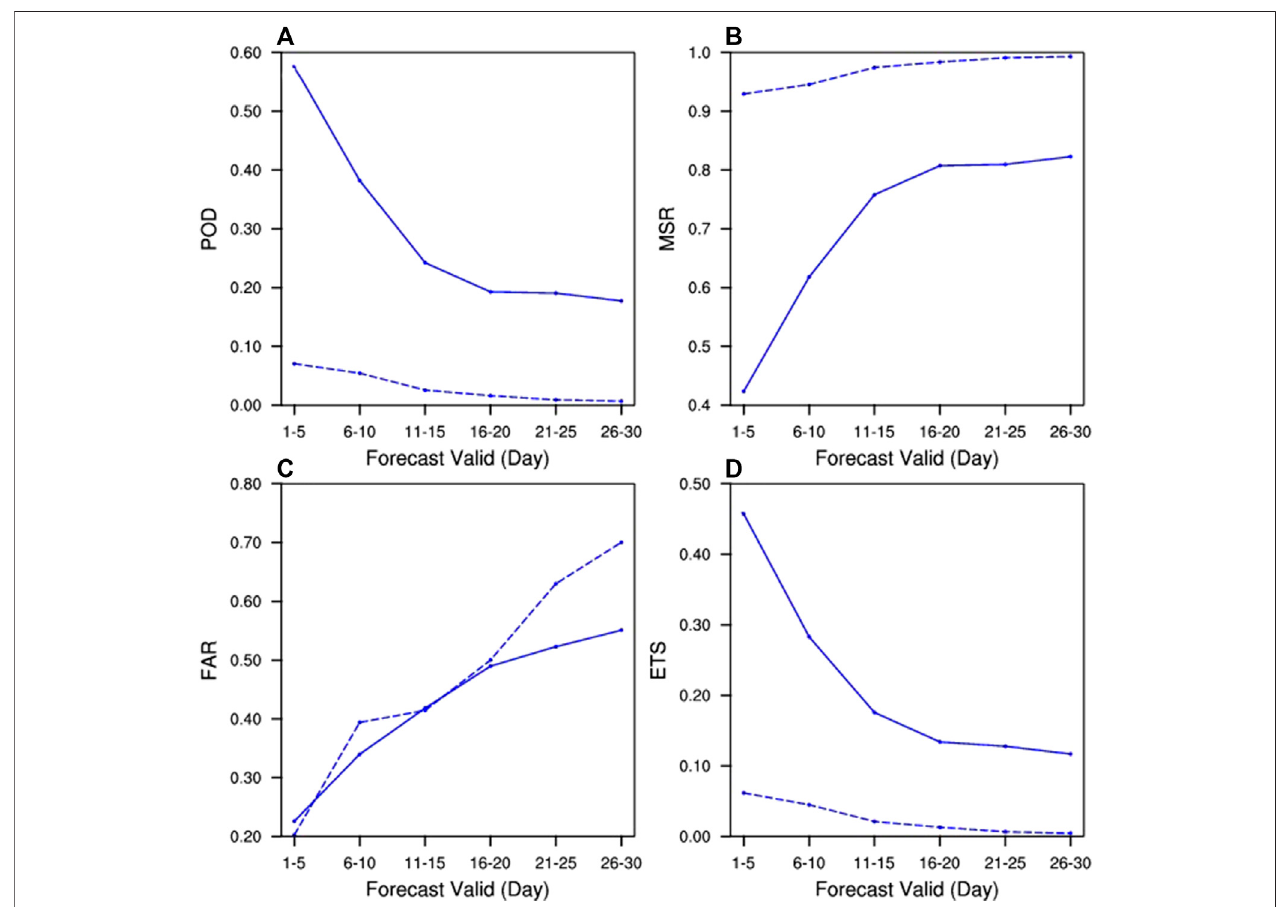
FIGURE 5 | Comparison of the raw (dash lines) and bias-corrected (solid lines) ECMWF forecast for POD (A) , MSR (B) , FAR (C) , and ETS (D) of heatwave events.